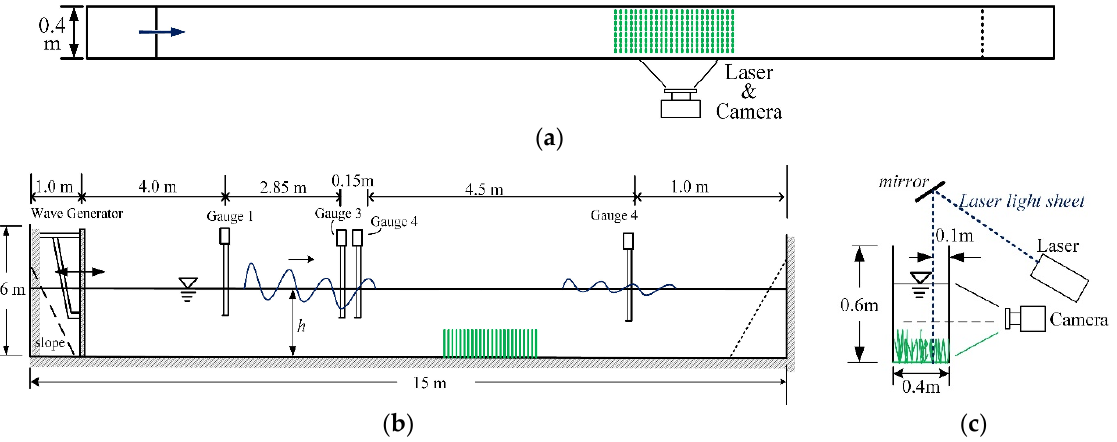
Figure 2 . Schematic of flow field visualization wave tank: ( a ) top view, ( b ) side view and ( c ) front view.